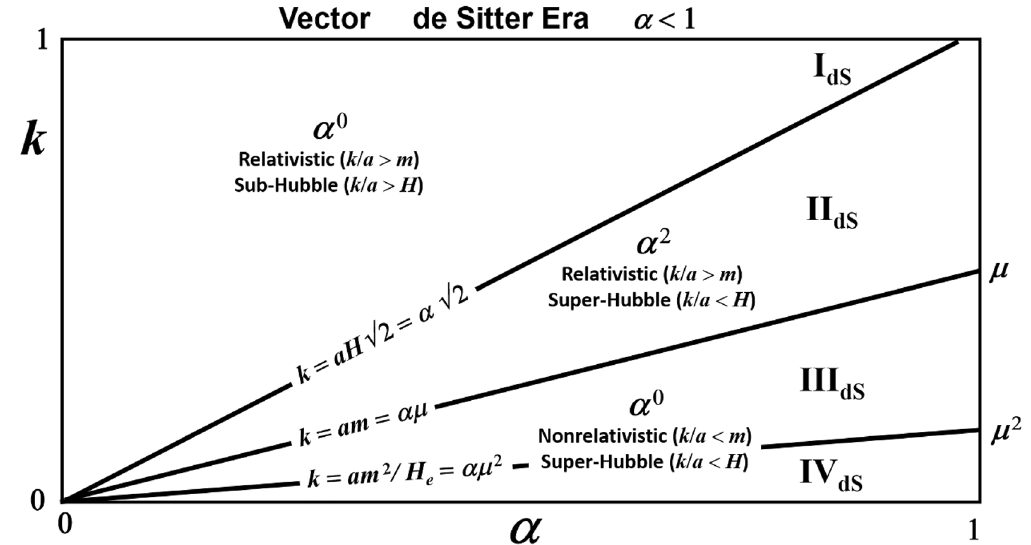
√ √ p 2 is the line for k = α | R | / 6 H 2 = aH/ 2 ; above e